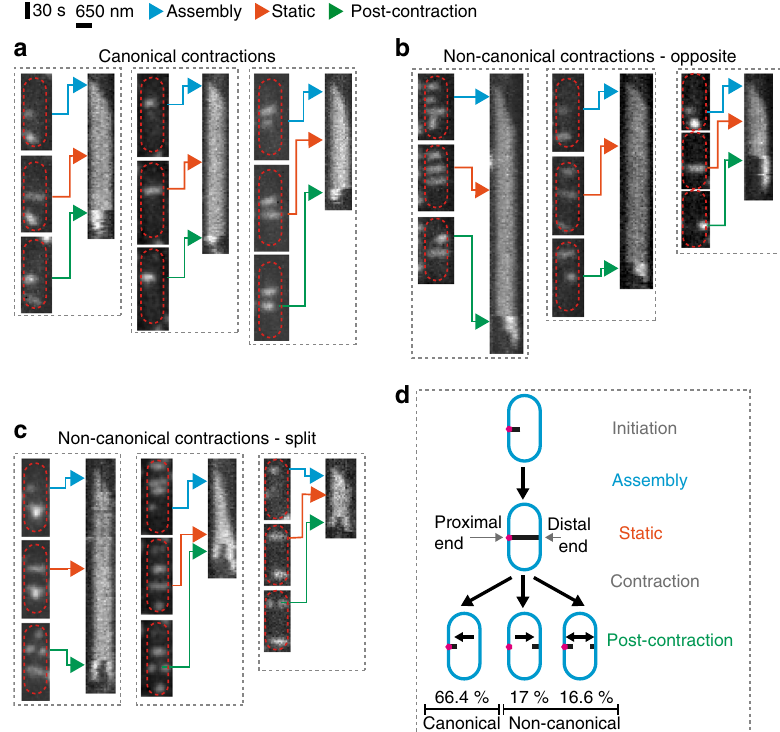
Fig. 1 The dynamics of the EAEC T6SS-1 reveal non-canonical contraction events. a – c EAEC TssB1-sfGFP cells were analyzed by time-lapse fl uorescence imaging (1 frame every 3 s). For each example (boxed by grey dashed lines), three snapshots for each cell are shown, representing assembly/static/post- contraction states, respectively. For each example, the three snapshots are correlated with a kymograph of a selected T6SS structure as indicated by arrows. Cell outlines are indicated by red dashed lines. Images were positioned to orient T6SS assembly start sites (proximal ends) on the left. See also Supplementary Movies 1 – 3. Three classes of contraction events were observed. Canonical contraction (observed previously 8,27 ) occurred toward the proximal end ( a ). Non-canonical opposite contraction occurred toward the distal end ( b ), or the T6SS split and contraction occurred simultaneously toward the proximal and distal ends ( c ). d Interpretation of the observed EAEC T6SS-1 dynamics. Quanti fi cation shows that non-canonical contractions accounted for 33.6% of all measured events ( n = 593). For statistical analysis see Supplementary Fig. 1b. Blue, cell envelope; magenta, proximal